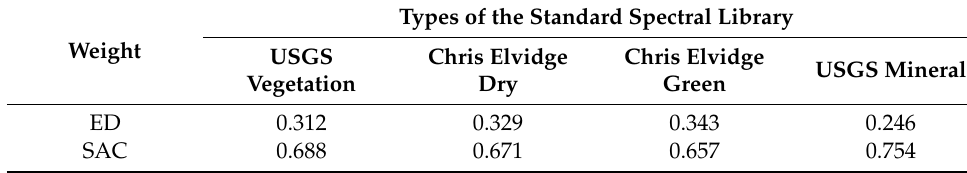
Table 8. Weight of selected similarity measures based on standard spectral libraries (Euclidean distance (ED) and spectral angle cosine